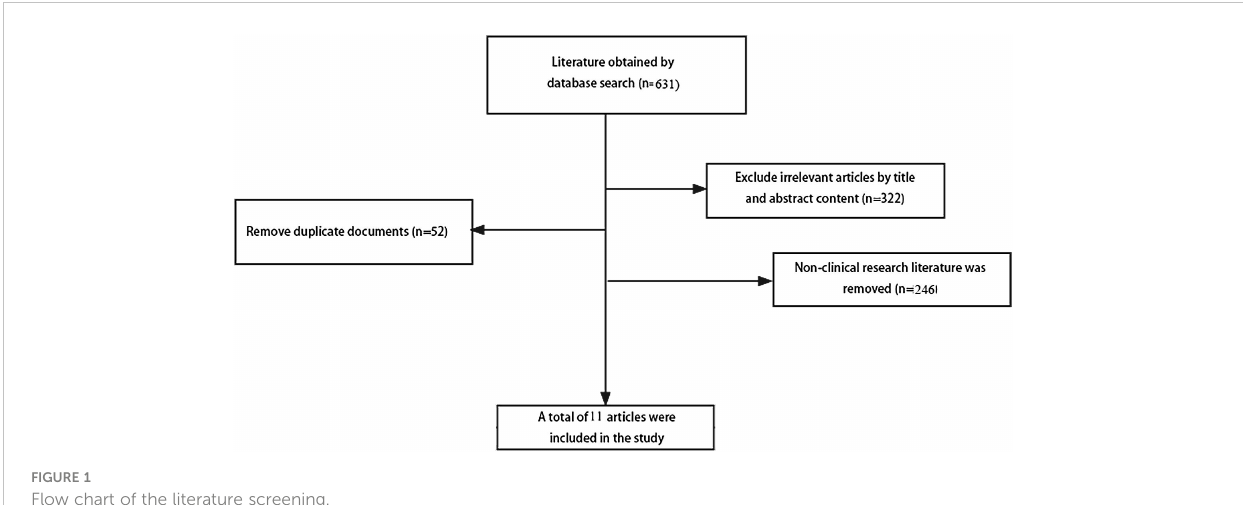
FIGURE 1 Flow chart of the literature